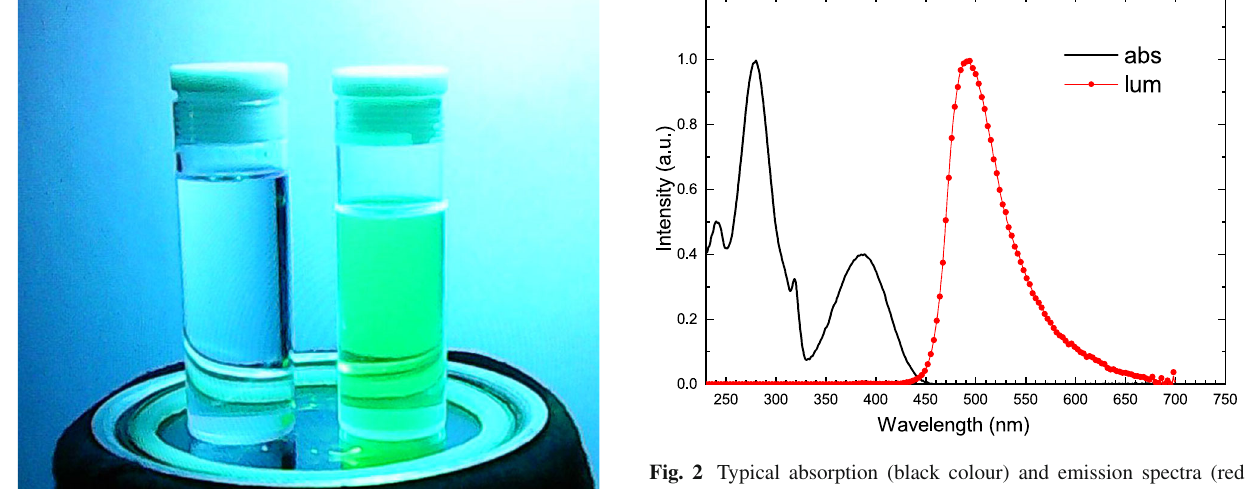
Fig. 2 Typical absorption (black colour) and emission spectra (red colour) of the NOL 37 fluor 3 Light yield and emission kinetics measurements